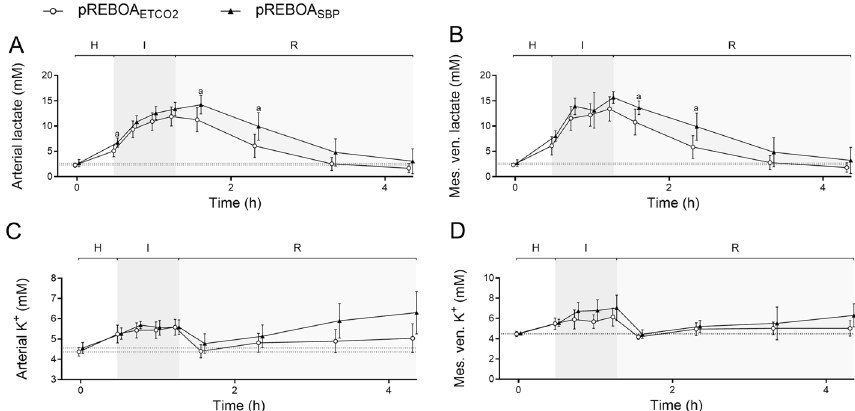
Fig. 2 End-tidal carbon dioxide (ETCO 2 , A ), systemic blood pressure (SBP, B ), abdominal aortic blood flow (ABF, C ) and femoral arterial mean pressure (FMP, D ) in anesthetized, mechanically ventilated pigs undergoing hemorrhage (H), intervention (I) using either end-tidal carbon dioxide (ETCO 2 ) targeted partial resuscitative endovascular balloon occlusion of the aorta (pREBOA, pREBOA ETCO2 , n 10) and proximal systolic blood = pressure targeted pREBOA (pREBOA SBP , n 10) and subsequent reperfusion (R). a Denotes statistical = difference between the groups at a given timepoint. Data are means (95% confidence interval). The dotted line represents baseline